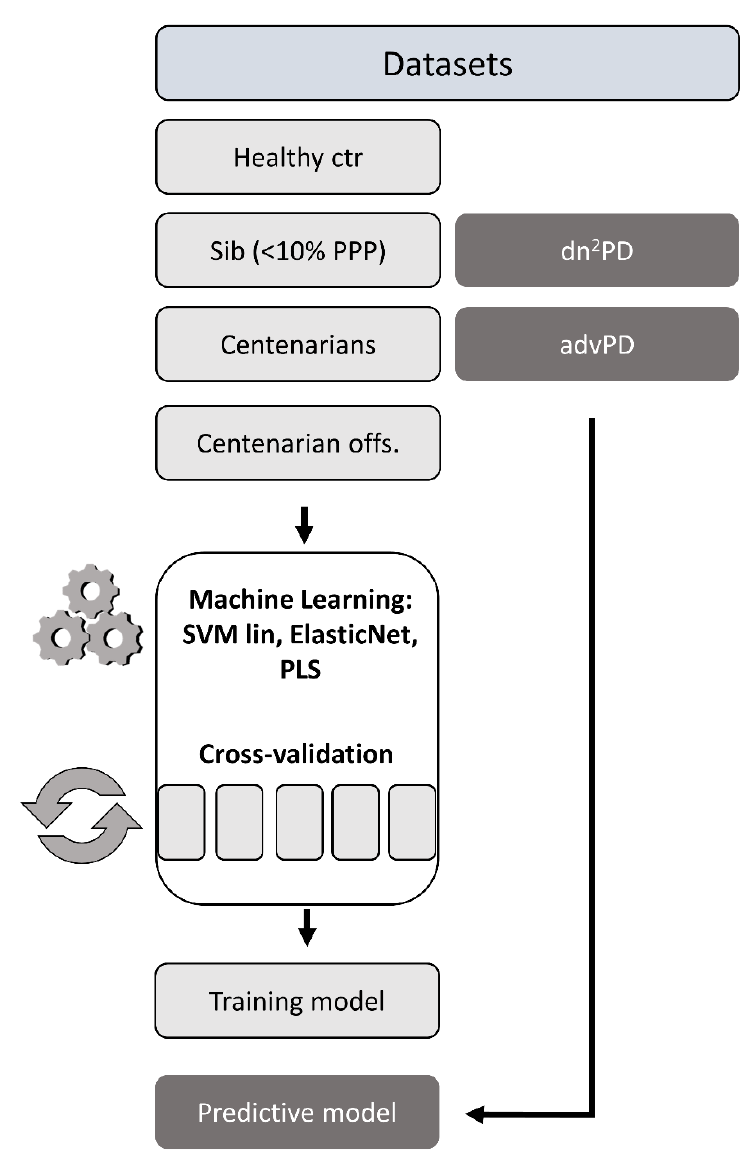
Figure 1. Schematic representation of the age prediction models.